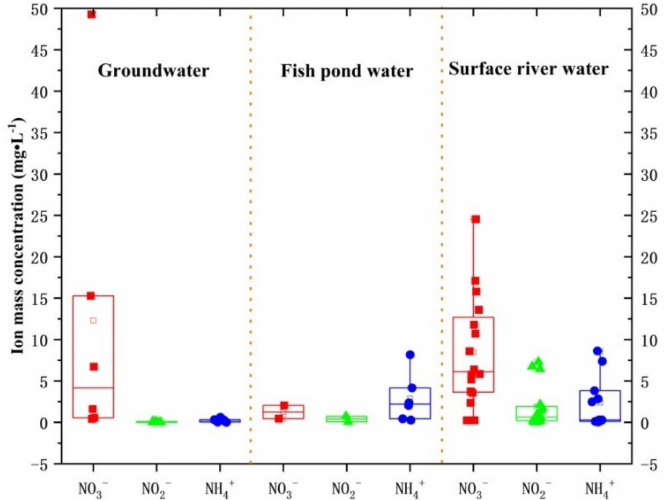
Figure 3. Nitrogen concentration box diagram of three types of water